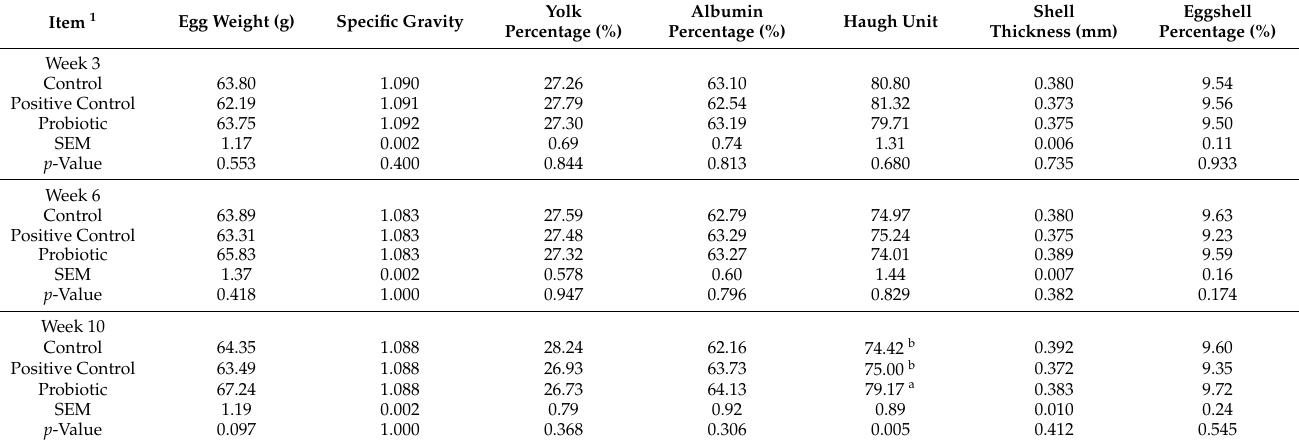
Table 3. Effect of different dietary treatments on external and internal egg quality